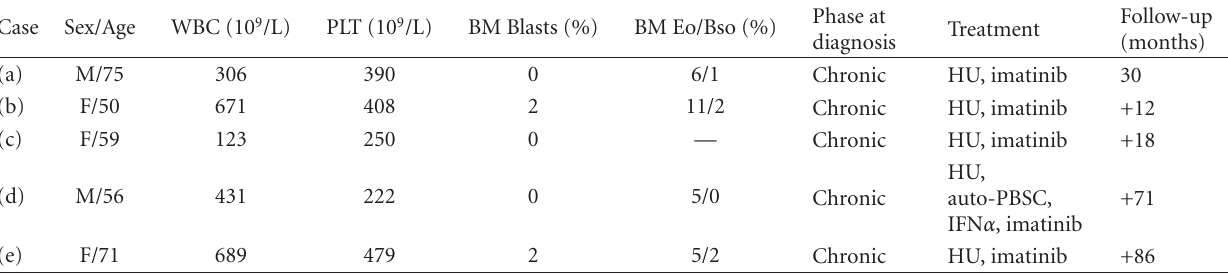
Table 1: Clinical characteristic of the patients. M: male, F: female, WBC: white blood cell count, PLT: platelet count, BM: bone marrow, Eo: